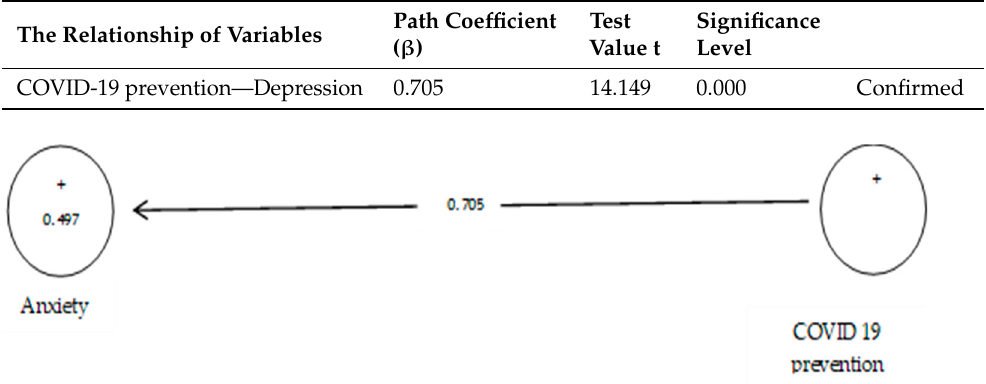
Figure 9. Drawn model with significant coefficients z. Table 8. Evaluation indicators of the internal model of the research, direction, and significance of direct effects.